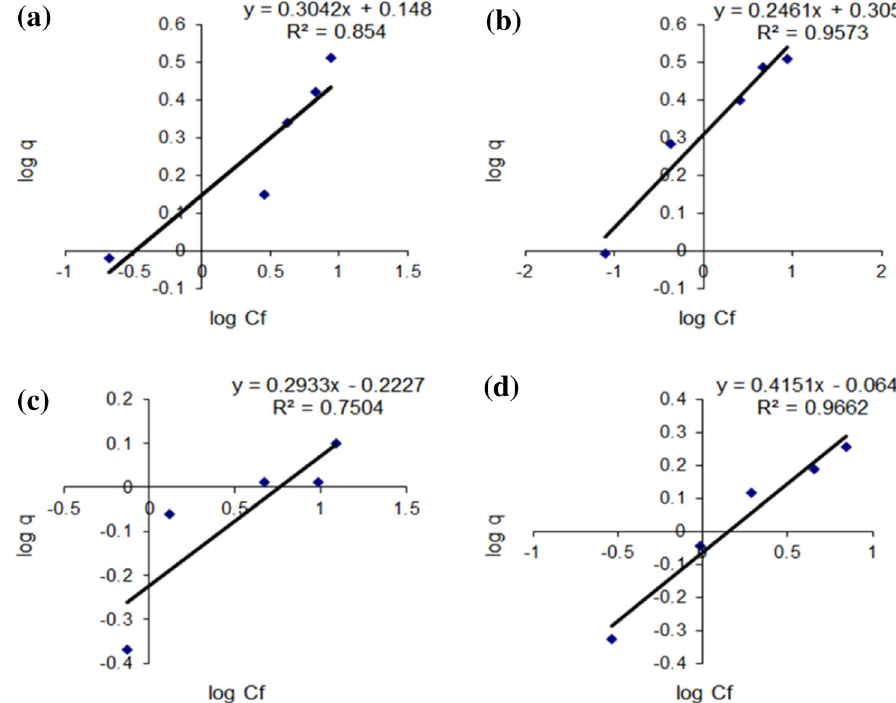
Fig. 9 Freundlich isotherms for metal removal ( a Cd on natural